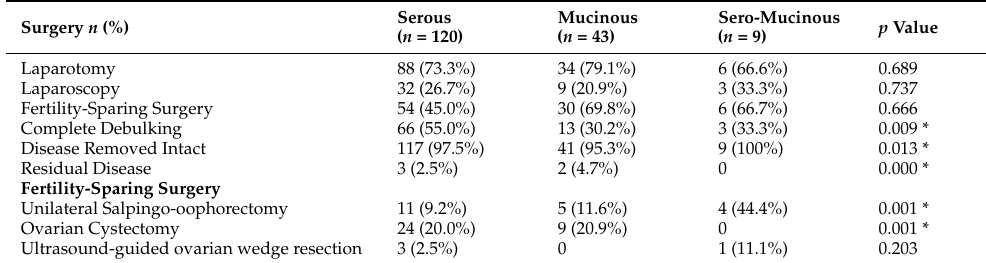
Table 3. Surgical management of primary Borderline Ovarian Tumour.